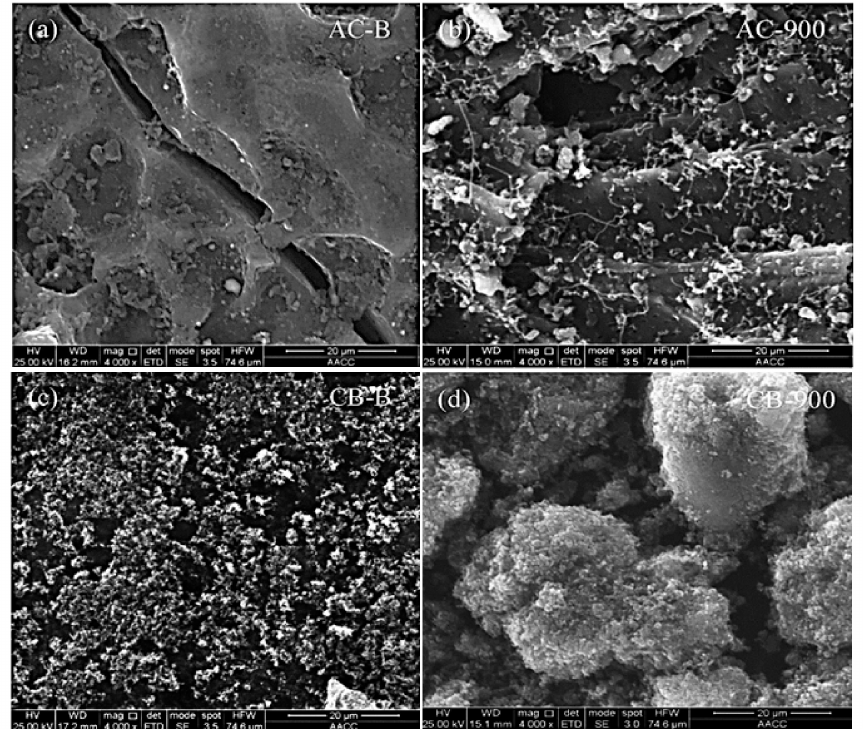
Figure 14. SEM image of ( a ) fresh activated carbon catalyst (AC), ( b ) spent AC catalyst after 500 min testing at 900 ◦ C, ( c ) fresh carbon black catalyst (CB), and ( d ) spent CB after 500 min testing at 900 ◦ C; reprinted with permission from ref. [104]. Copyright 2020